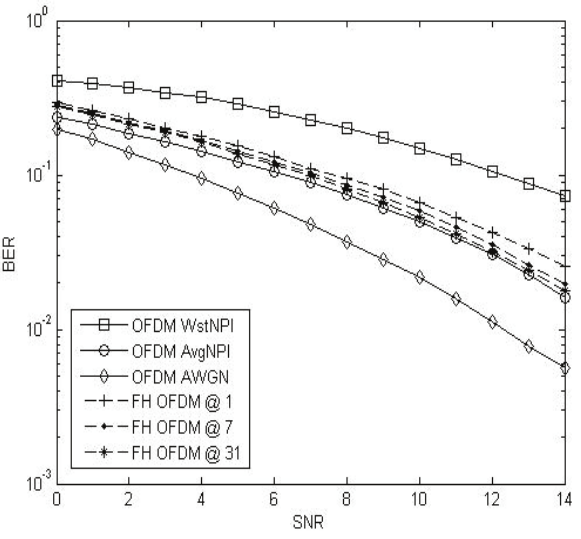
Figure 8. BER simulation performance of an OFDM system under the worst, the average and no interference conditions. The performance of a FH-OFDM with different hopping rates operating at the worst interference conditions is also